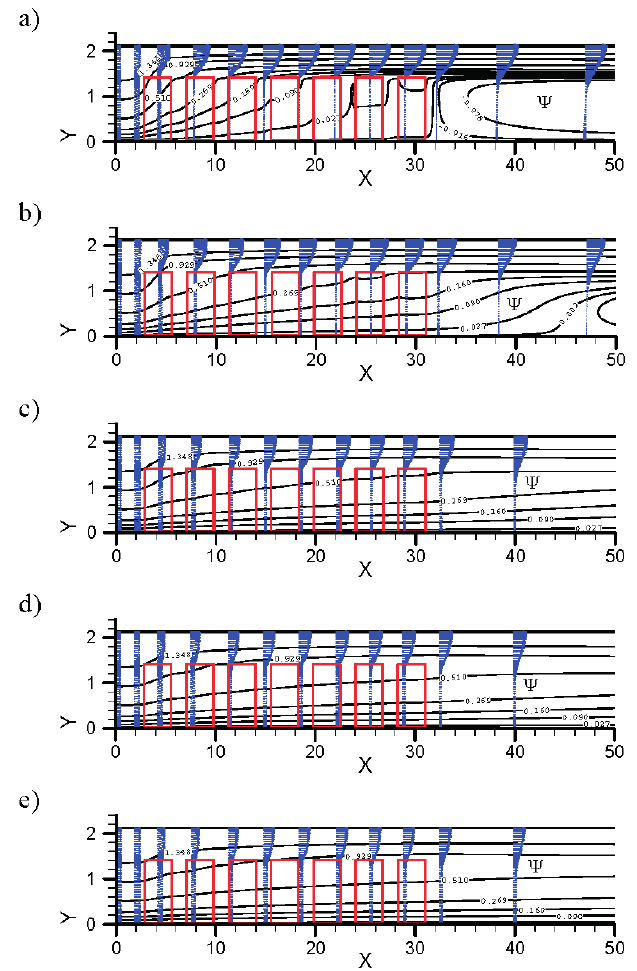
Figure 8. Streamlines and velocity vectors for various test samples with X T * = X L * = 1.5 (the scales of X -axis and Y -axis are different): ( a ) Sample 1; ( b ) Sample 2; ( c ) Sample 3; ( d ) Sample 4; and ( e ) Sample